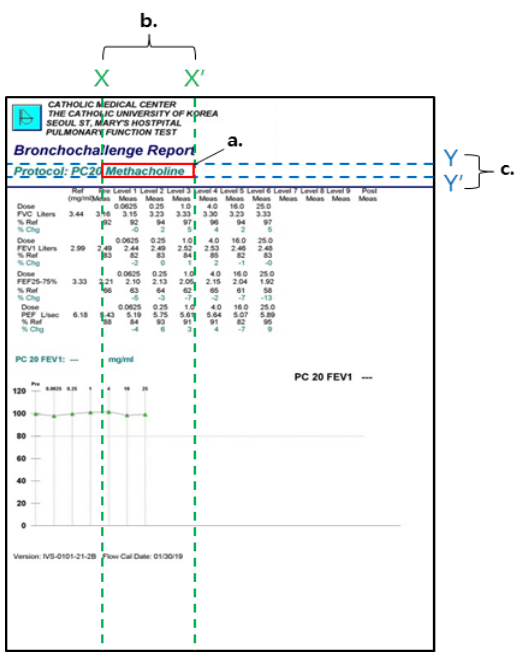
Figure 2. Keyword and coordinates; a . the best representative keyword; b . x coordinate values at the beginning and end of the keyword; c . y coordinate values at the beginning and end of the keyword.